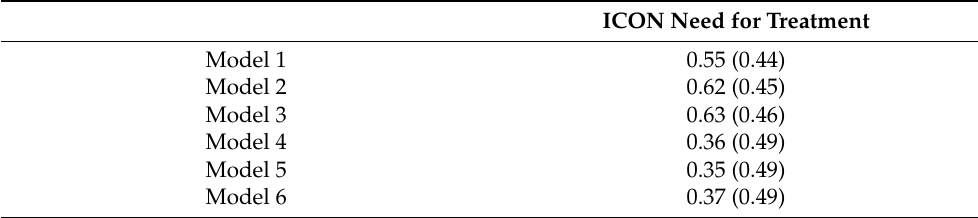
Table 6. Crude and adjusted logistic regression models and correspondent standard error of fre- quently affected OHIP-14 total score towards the presence of missing teeth ( n =